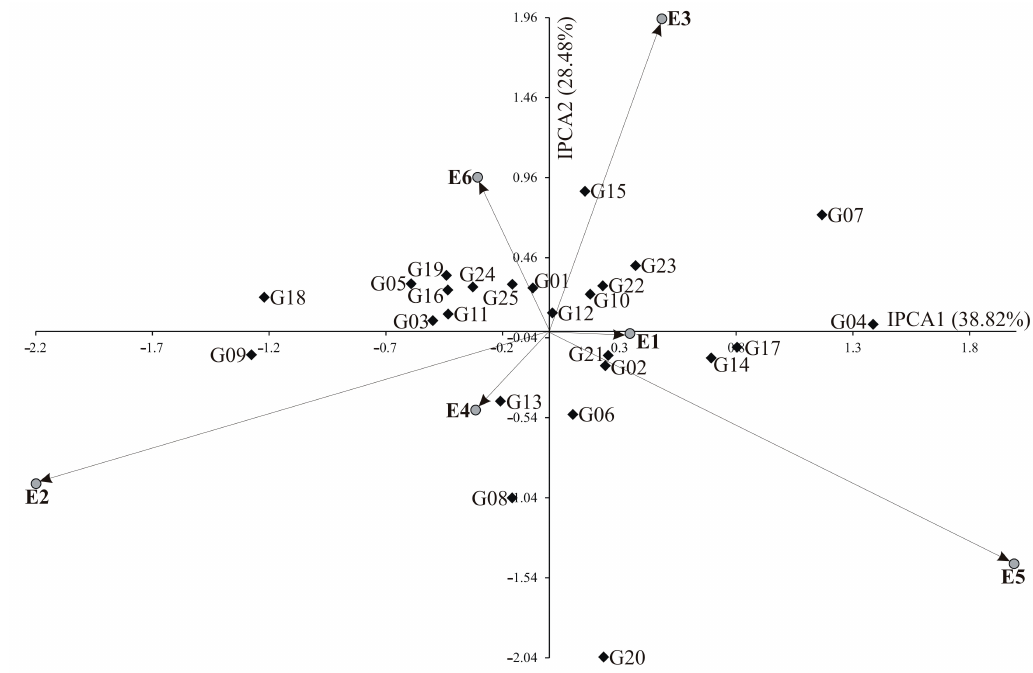
Figure 4. Biplot for genotype by environment interaction of C18:2 content in 25 winter oilseed rape ( B. napus ) genotypes in six environments, showing the effects of primary and secondary components (IPCA 1 and IPCA 2, respectively) (E1—Borowo, 2015; E2—Borowo, 2016; E3—Borowo, 2017;